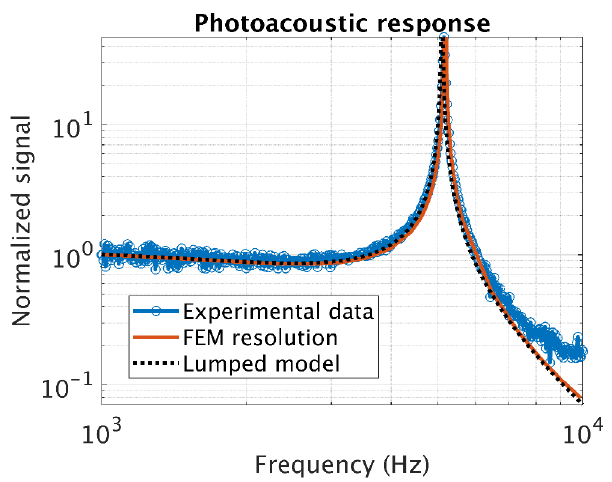
Figure 14. Normalized frequency response of the PA sensor in presence of atmospheric water at 1906 cm − 1 .